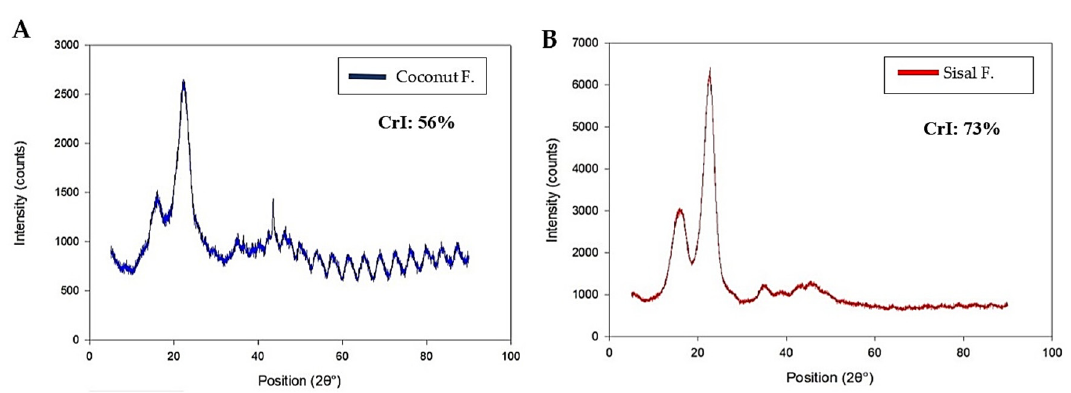
Figure 2. X-ray diffraction analysis and Crystallinity Index (CrI) of the natural ( A ) coconut fiber and ( B ) sisal fiber. The crystallinity of sisal fibers is highly crystalline compared to coconut fibers; crystallinity is a factor that will affect the properties of the fibers.